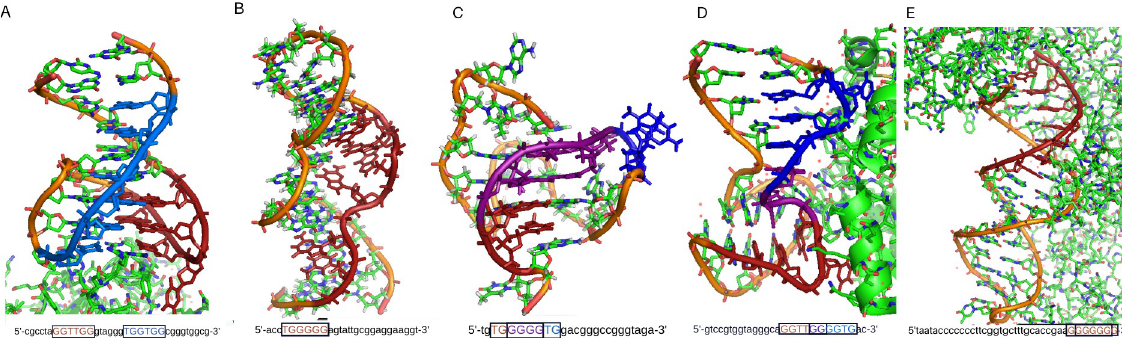
Fig 8. Structures of elucidated Aptamers with their sequences. The identified 6-mers are highlighted in red and blue, in the sequence and structure, the area where the 6-mers overlap is colored in purple. ( A ) NU172 Aptamer PDB:6GN7; ( B ) AMP Aptamer PDB: 1AW4; ( C ) V7t1 VEGF Aptamer PDB: 2M53; ( D ) HD22 Aptamer PDB: 4I7Y and ( E ) HIV-1 RT Aptamer PDB:5D36.